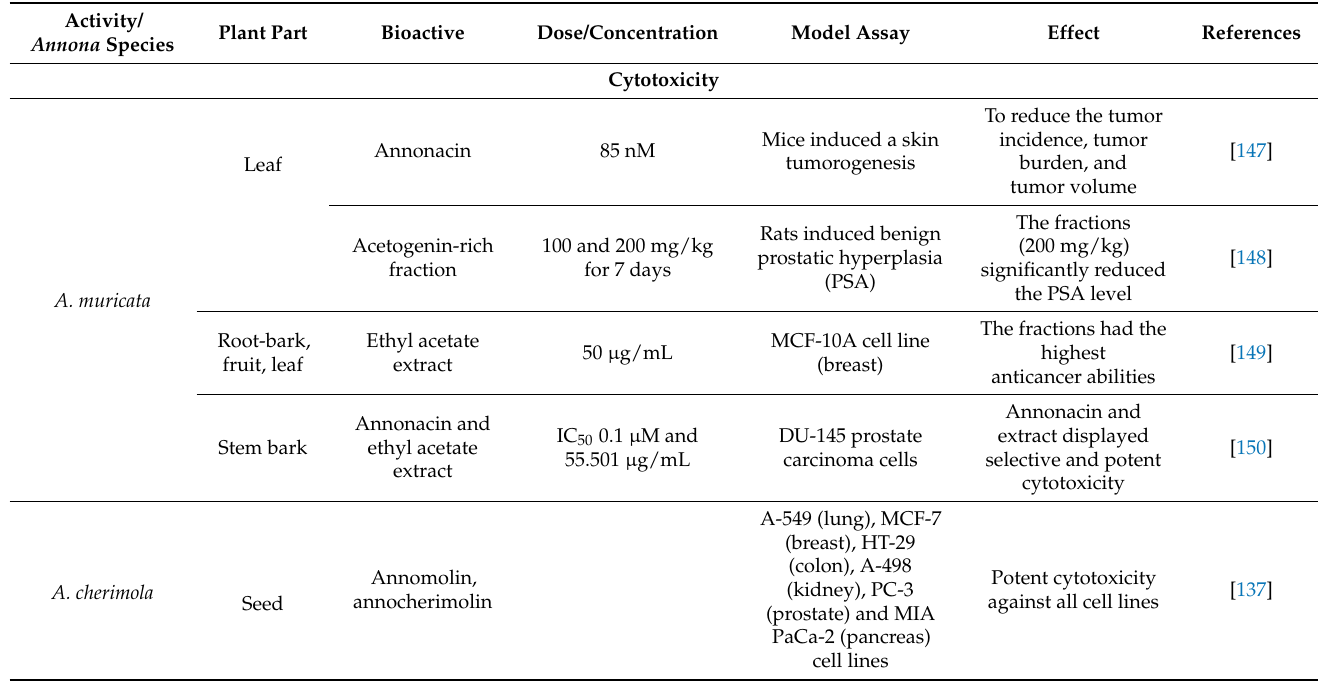
Table 4. Cytotoxicity, anti-hyperglycemic, and anti-inflammatory activities of different crude extracts or isolated compounds from different plant parts of some Annona species using different model